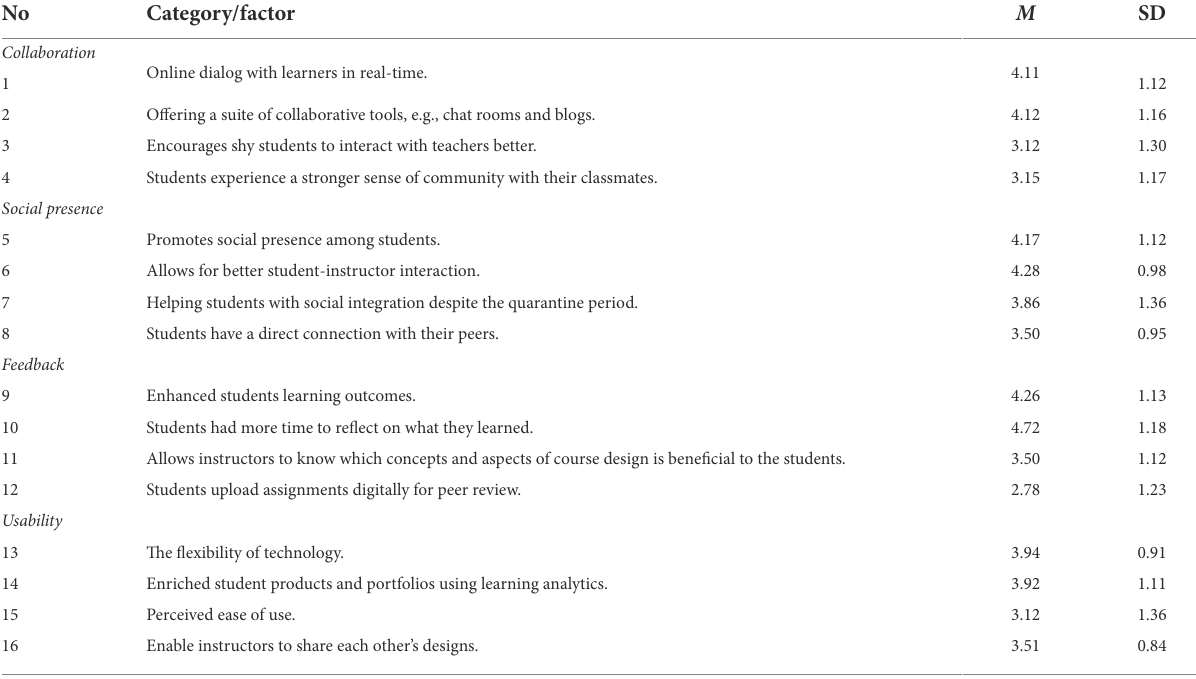
TABLE 1 Factors that influenced instructors’ utilization of virtual classroom ( N = 12